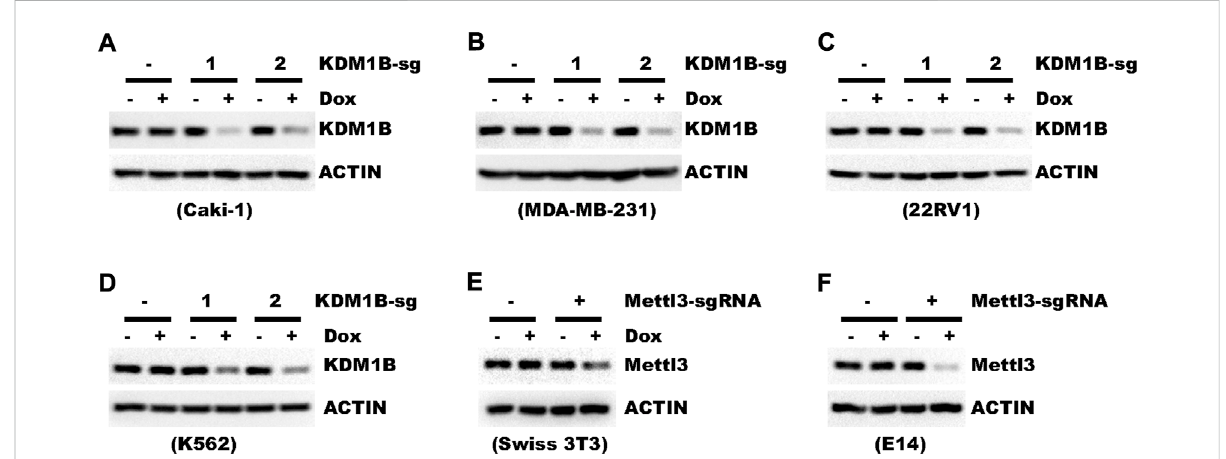
Genescanbeef fi cientlyknocked-downindifferentcelltypes. (A – D) CellsweretransducedwithavirusexpressingpLenti-TRE-CasRx-KDM1B- sgRNA. Cells were then selected with 1 μ g/ml puromycin for 5 days. Afterward, cells were then treated with 1 μ g/ml Doxycycline for 4 days. Shown are WB results. (E,F) Cells were transduced with a virus expressing pLenti-TRE-CasRx-Mettl3-sgRNA. Cells were then selected with 1 μ g/ml puromycin for 5 days. Afterward, cells were treated with 1 μ g/ml Doxycycline for 4 days. Shown are WB results.